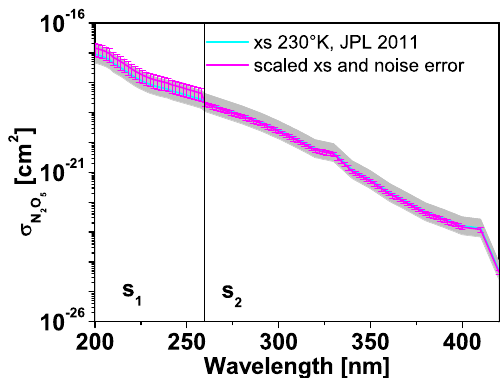
Fig. 5. Sensitivity of the NO 2 concentration in our model to the scaling factors s 1 (left panel) and s 2 (right panel) on the absorption cross-section of N 2 O 5 . Units are given in 10 7 molec / cm 3 . The altitude region used for the analysis is marked by black lines.